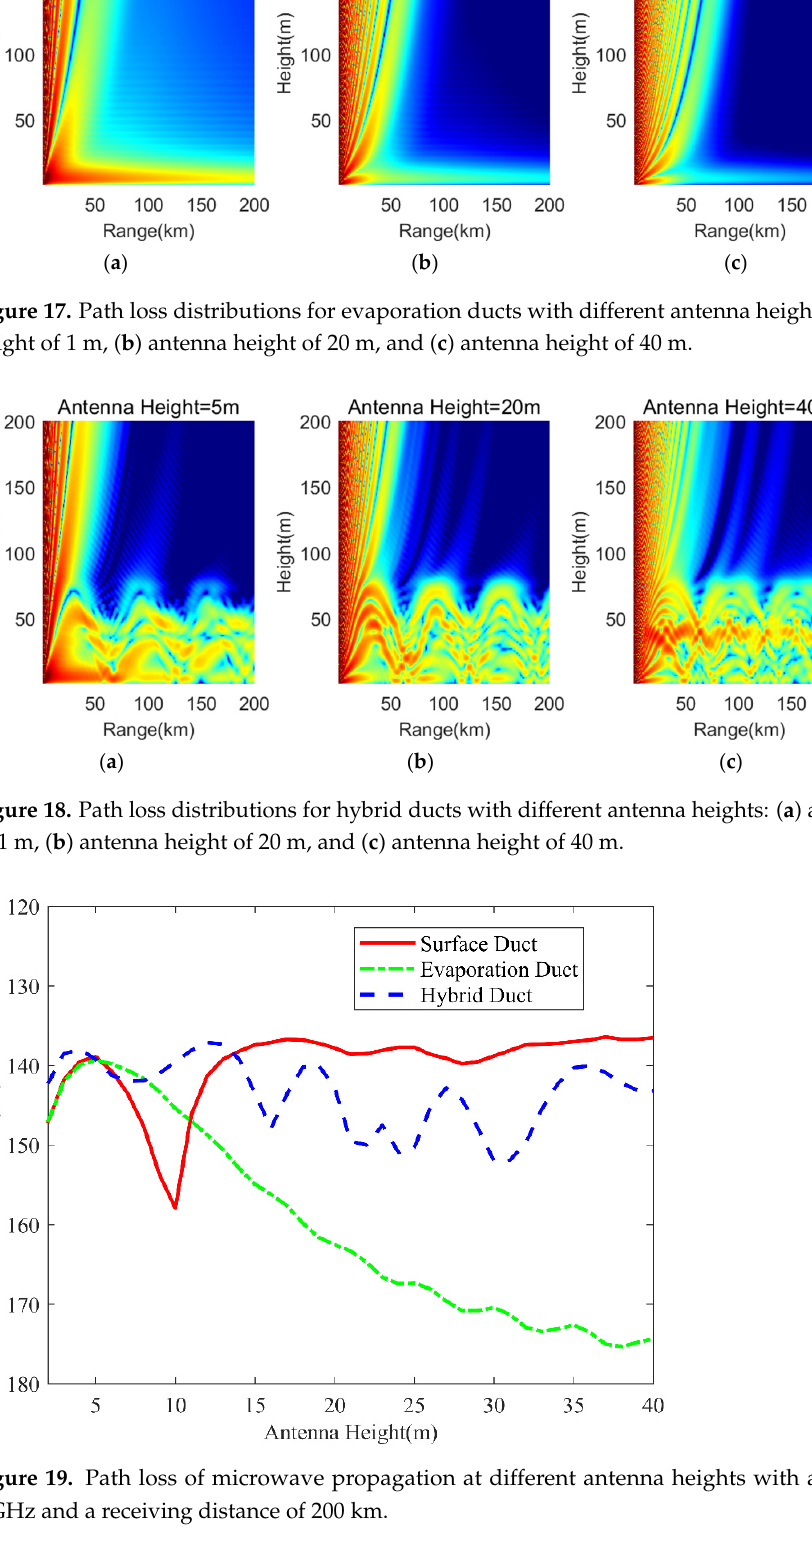
Figure 16. Path loss distributions for surface ducts with di ff erent antenna heights: ( a ) antenna height of 1 m, ( b ) antenna height of 20 m, and ( c ) antenna height of 40 m.